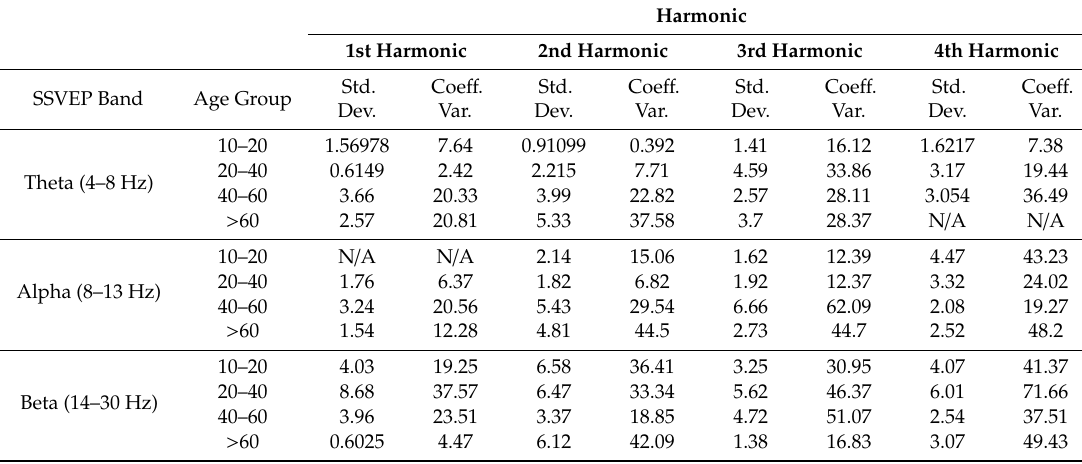
Table 3. Statistics of spread (standard deviation and coe ffi cient of variation) for band power of first four SSVEP harmonics evoked by theta, alpha, and beta